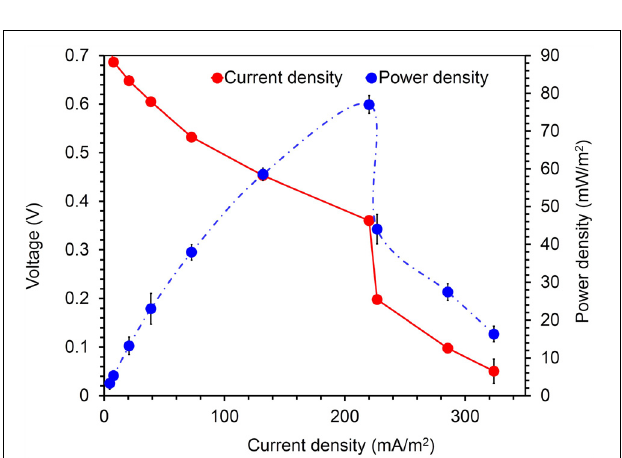
FIGURE 6 | Current density, Power density and Coulombic efficiency relationship for MFCs fed with different substrates. Yellow bars represents the current density produced from the oxidation of acetate, citrate and DRH; Pink bars represent the coulombic efficiency of each MFC system fed with acetate, citrate and DRH; Green line represents power density generation from the oxidation of acetate, citrate, and DRH.